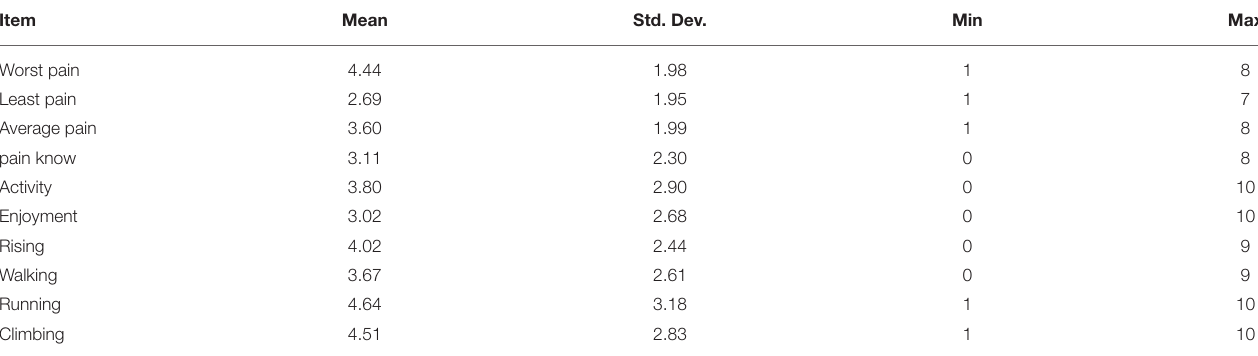
TABLE 1 | Results for each item of the Italian Canine Brief Pain Inventory (expressed as mean, standard deviation, minimum and maximum) obtained from 45 owners of dogs with osteoarthritis. Item